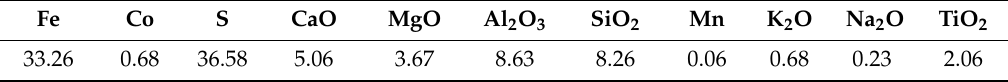
Table 2. Main chemical composition of Co-bearing sulfur concentrate